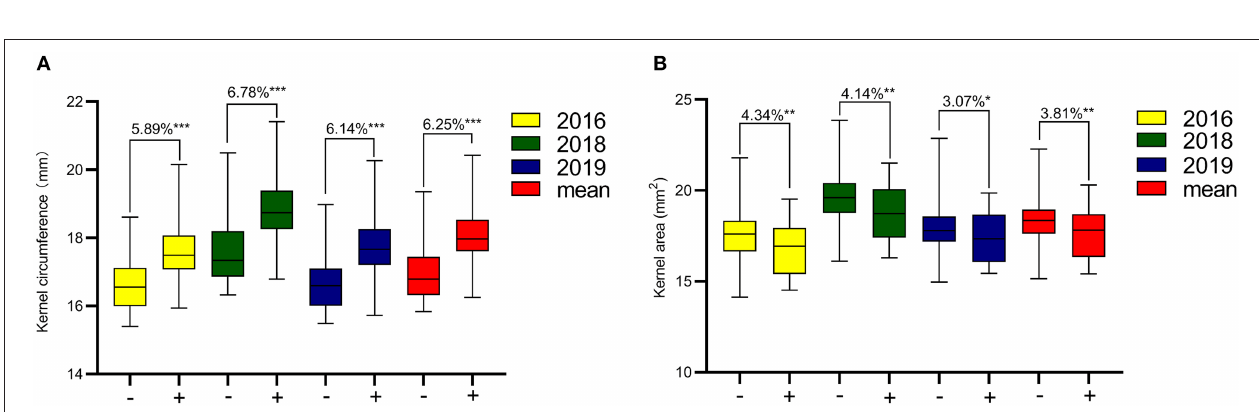
FIGURE 5 | Effects of QKc.sau-6A.1 (A) and QKa.sau-6A.2 (B) in RIL population. “ + ” Indicates the lines with the genotypes “ AA ” or “ BB, ” “–” indicates the lines without the genotypes “ aa ” or “ bb. ” *, **, and ***, significant at P < 0.05, 0.01, and 0.001, respectively.